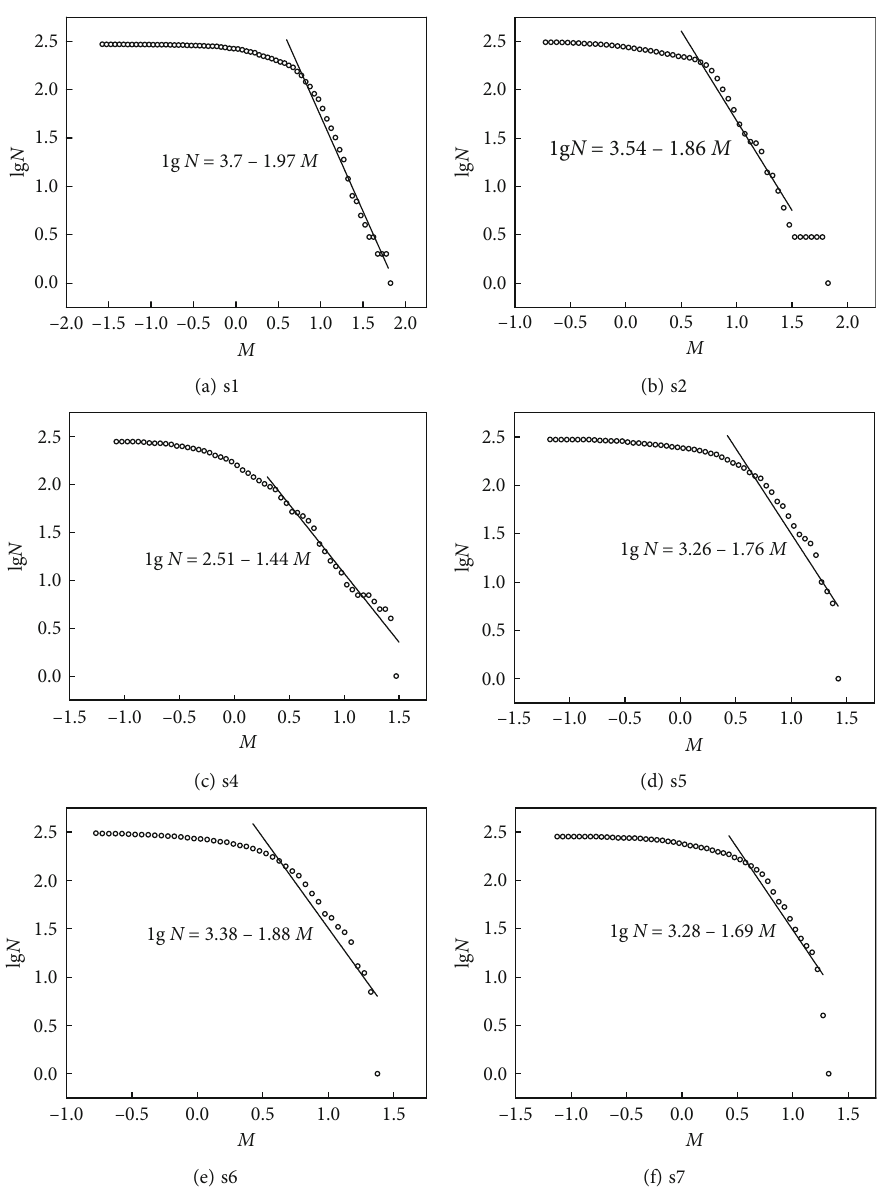
Figure 7: lg N - M distribution curves in each computational time domain. Table 1: D , D ∞ and b values in each time 2 ,